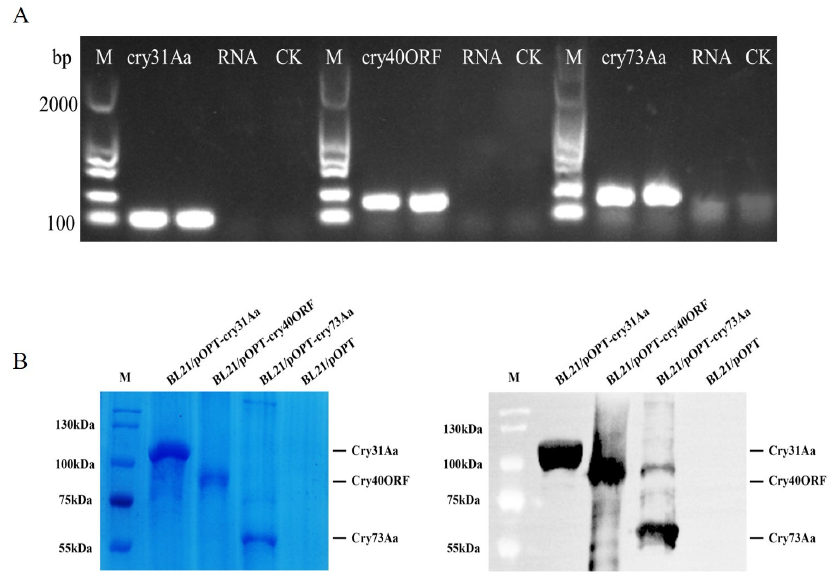
Figure 2. Detection of Cry protein genes and the identification of BL21 E. coli using the pOPT E. coli expression vector. ( A ) Detection of the transcription of Cry31Aa through RT-PCR. Total RNA was extracted from GBAC46 and BL21/pOPT. cDNA was used as a positive control, and RNA was used as a negative control. ( B ) SDS-PAGE expression analysis of Cry proteins (i.e., Cry31Aa, Cry40ORF, and Cry73Aa) after IPTG induction at 16 °C for 16 h. Levels of the three Cry proteins encoded by BL21/pOPT detected via Western blotting. The experiments were repeated independently three times.